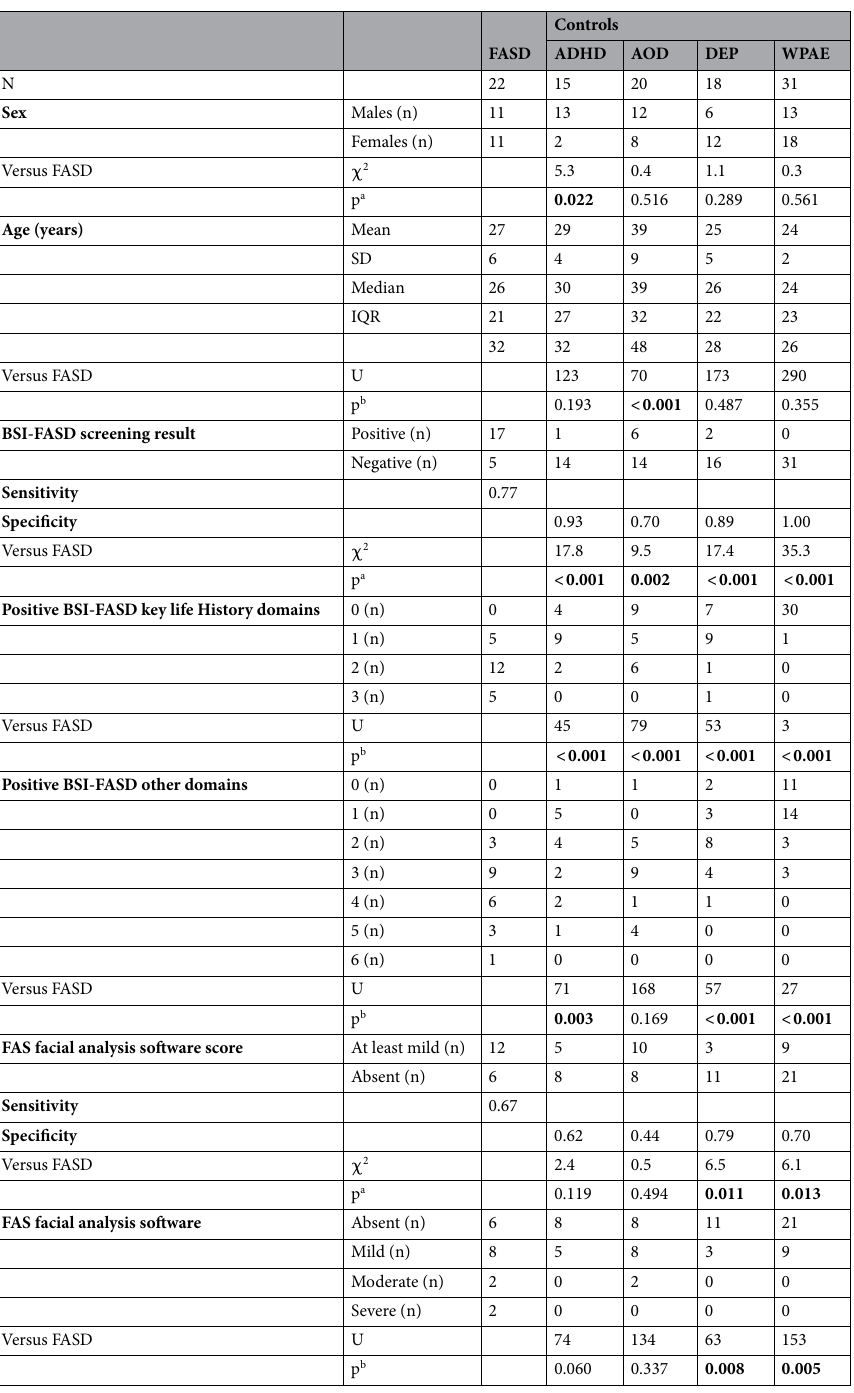
Table 1. Sociodemographic characteristics, positive BSI-FASD domains, and FAS Facial Analysis Software results in participants with FASD, ADHD, alcohol/opioid dependencies (AOD), depression (DEP), and without prenatal alcohol exposure (WPAE). The table shows absolute frequencies and mean, standard deviation (SD), median, and interquartile range (IQR). P values are derived from a χ 2 and b Mann–Whitney U tests. P < 0.05 in